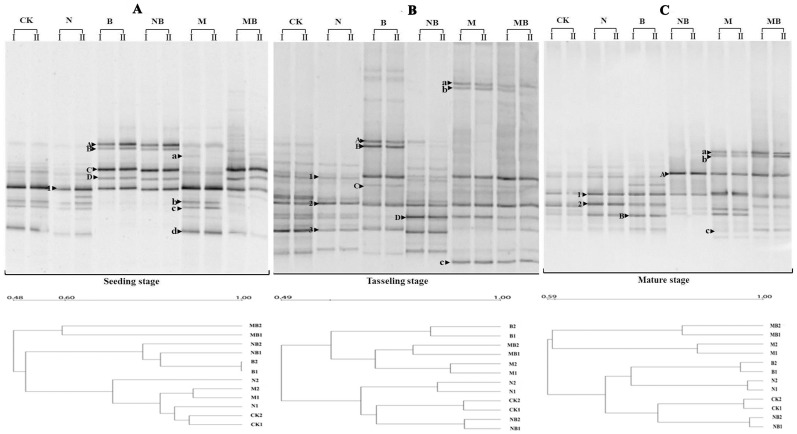
DGGE banding patterns of 18S rDNA fungi fragment and clustering of DGGE profiles in various treatments during maize growth stages.CK: no fertilizer; N: N fertilizer; B: bacteria fertilizer; NB: N fertilizer + bacteria fertilizer; M: manure compost; MB: manure compost + bacteria fertilizer.